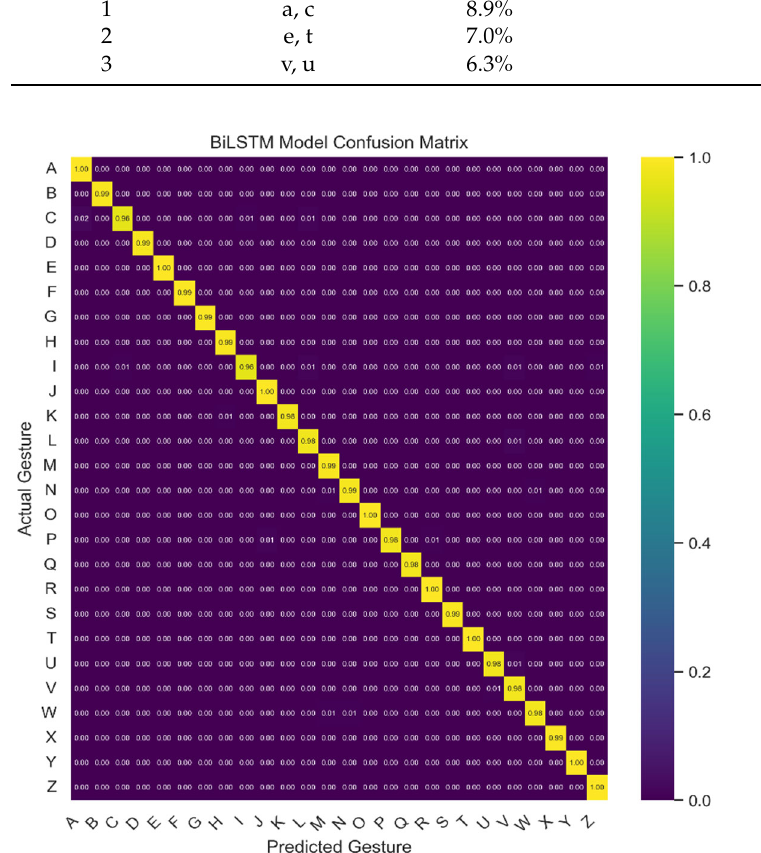
Figure 10. Confusion matrix generated using the BILSTM algorithm.